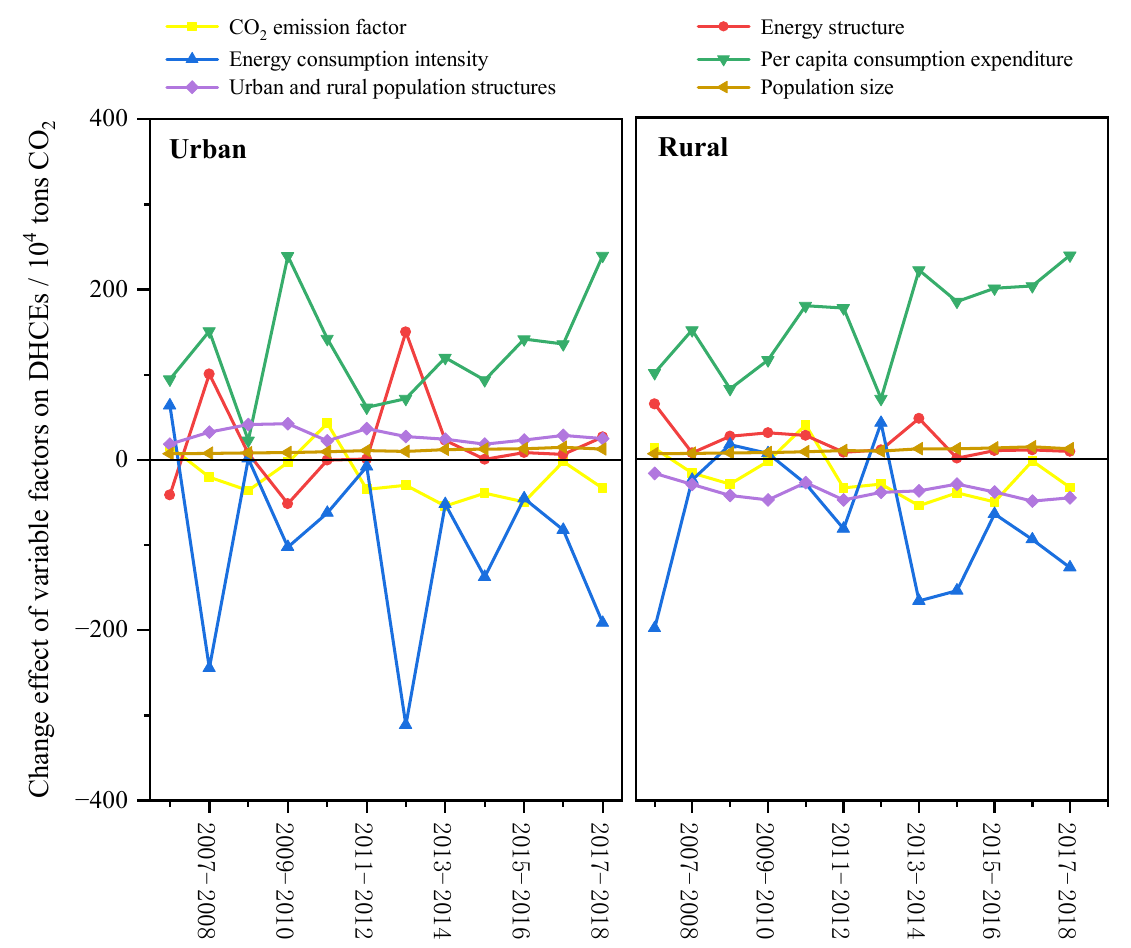
Figure 8. Change effect of variable factors on direct carbon emissions from household consumption. The increase in population size has promoted the growth of the DHCEs in urban and